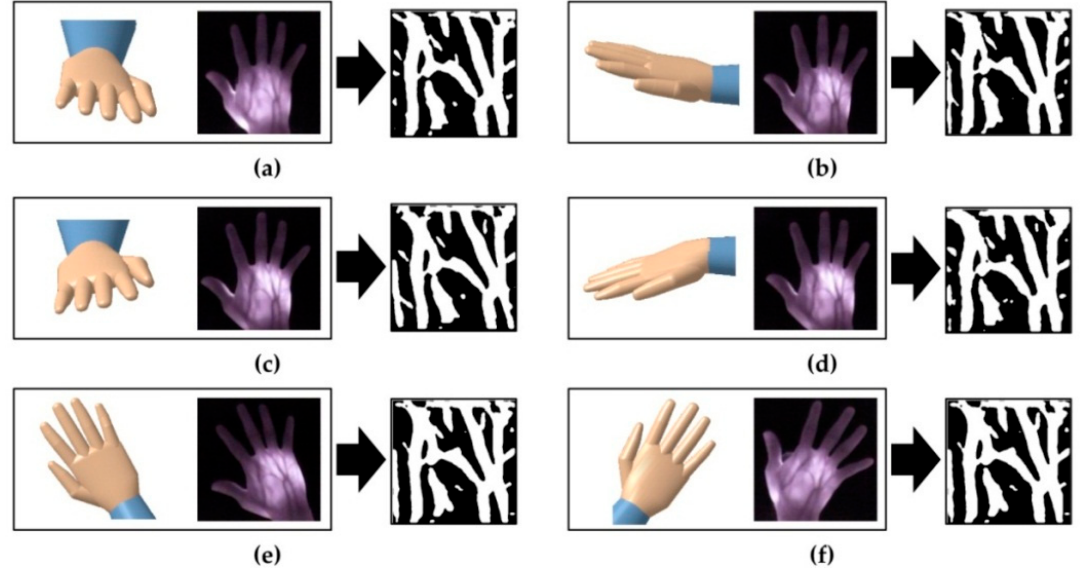
Figure 26. Vein pattern impressions of ( a ) and ( c ) row angle, ( b ) and ( d ) pitch angle, ( e ) and ( f ) yaw angle.